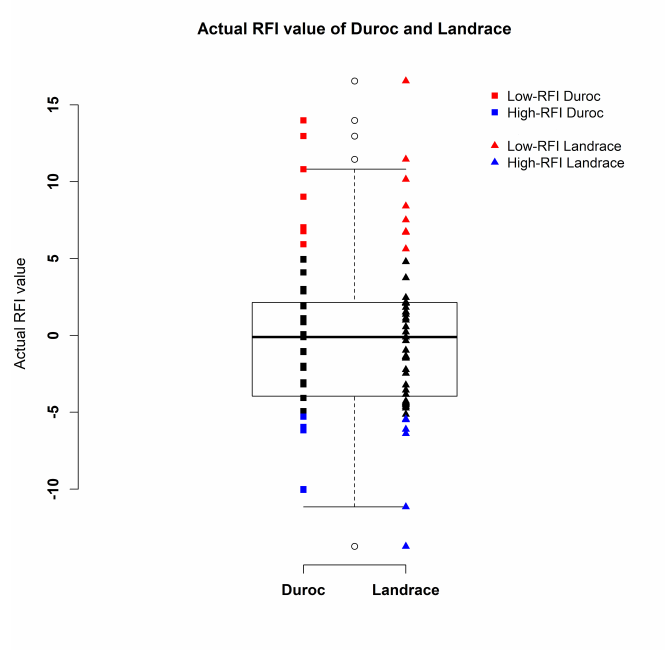
Figure 5. Distribution of actual RFI values of Duroc (n = 59) and Landrace (n = 49) pigs.